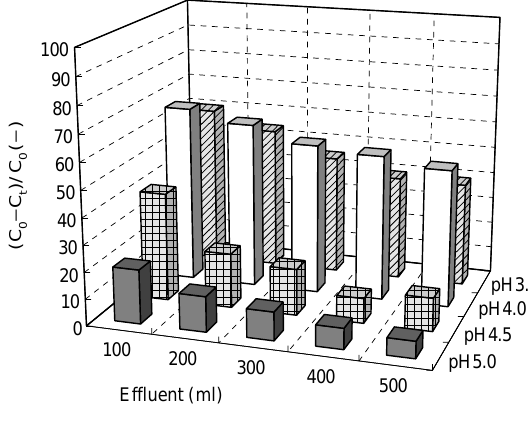
Fig. 4 Recovery of total silica particles as a function of effluent volume at various pH values. Experimental conditions were KNO 3 concentration of 10mM, silica concentration of 26mg/L, and superficial velocity of 1.7mm/s.